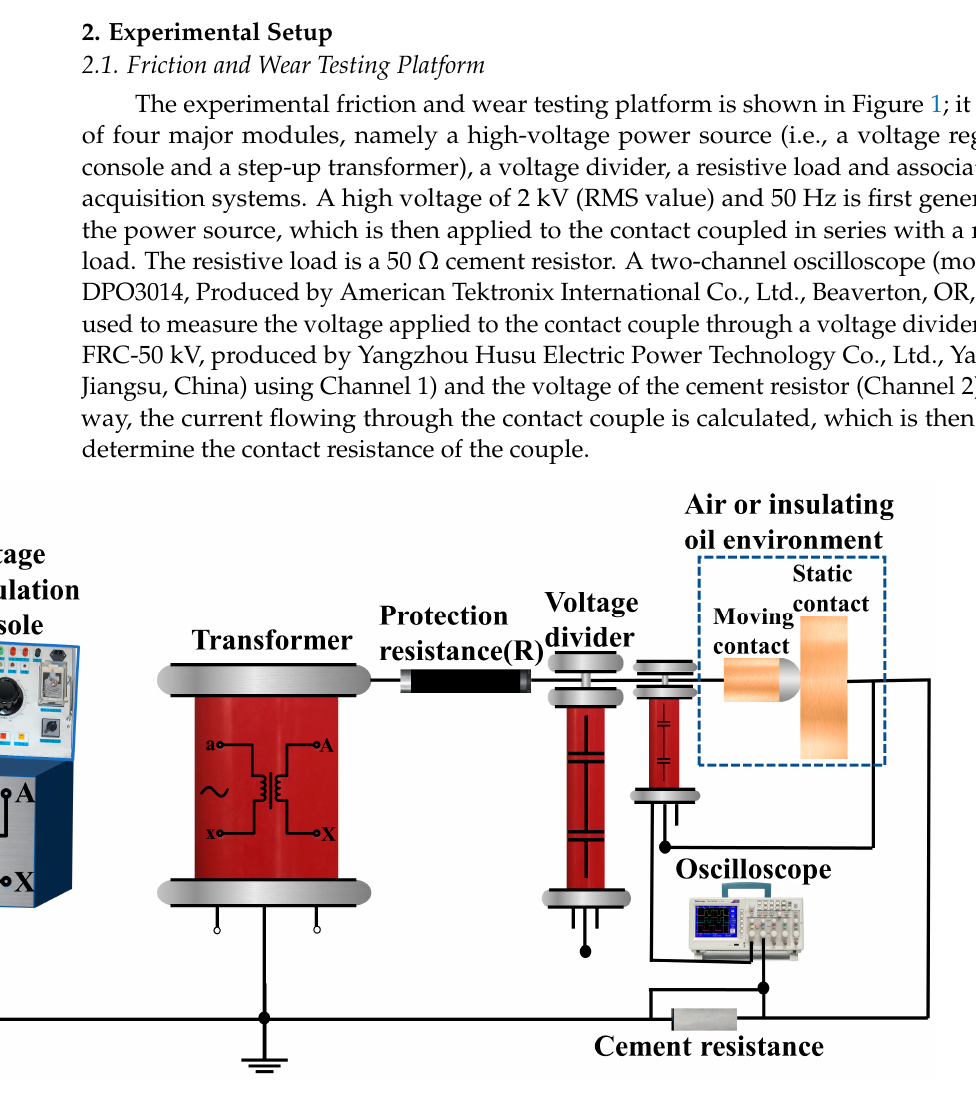
Figure 2. Image of real-life equipment for OLTC experimental test. 2.2. Testing Scenarios and Procedures The friction and wear experiments were performed under two testing scenarios (i.e., air and insulting oil environment) using the established platform. For each testing sce- nario, five sliding speeds were selected: 25 mm/s, 50 mm/s, 75 mm/s, 100 mm/s and 125 mm/s. Due to the error of the motor driving the moving contact, the actual sliding speeds were 24 mm/s, 50 mm/s, 76 mm/s, 95 mm/s and 119 mm/s. Before each testing, the moving contact remained sliding on the static contact at 24 mm/s for 5 min without energizing the power supply. The sliding of the moving contact was controlled by a self-made position